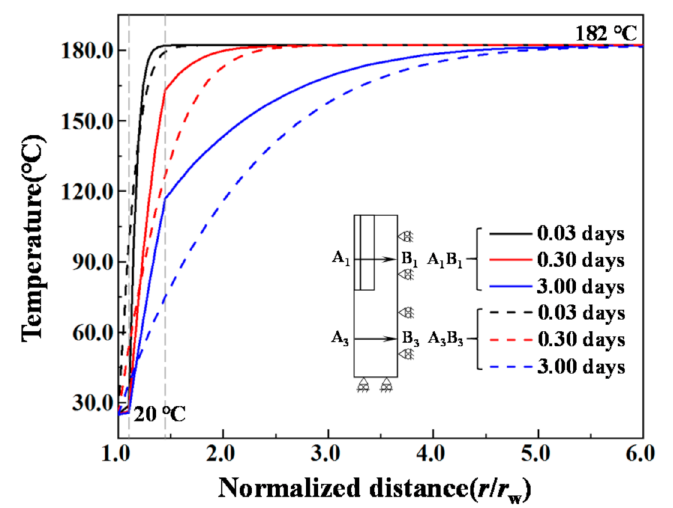
Figure 3. Temperature in the area near the wellbore changes with